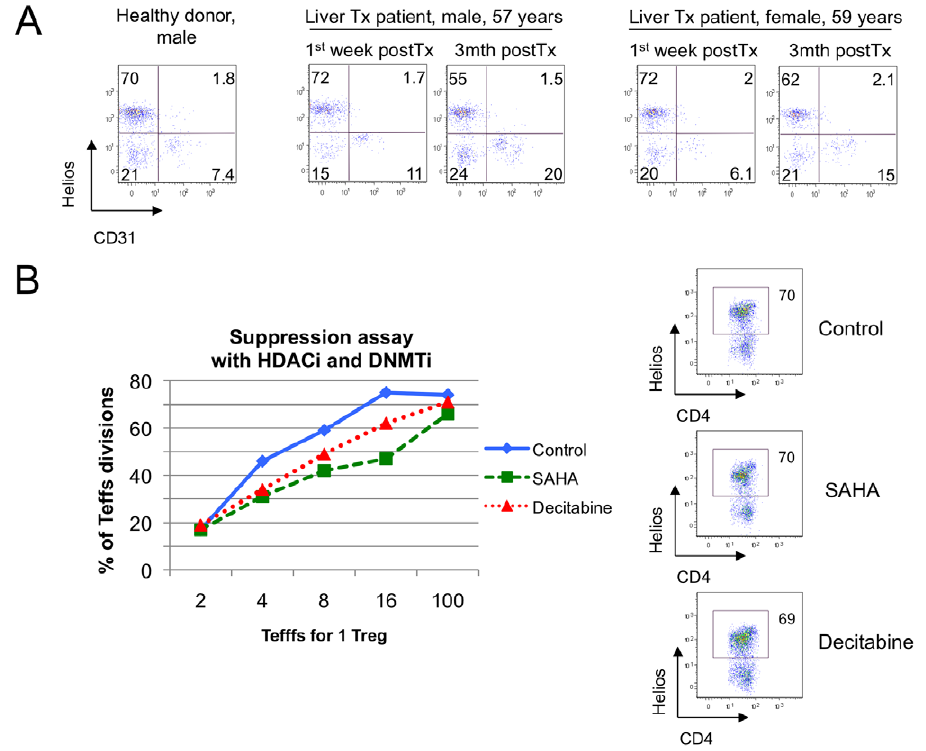
Figure 10. Helios expression by human Tregs did not correlate with CD31 or suppressive function. (A) Two liver transplant patients underwent serial analysis of Treg suppressive function, Foxp3 methylation and cell phenotype. At 3 mths post-transplant, Tregs had increased thymic output of CD31 + Tregs and reduction of Helios + Tregs; Helios was not co-expressed with CD31. (B) Tregs, CD4 + CD25- Teffs and CD4-depleted APC from healthy donor were used in suppression assays, with or without treatment with a DNMTi (Decitabine) or HDACi (SAHA). Enhancement of Treg suppression by either agent (left) was not accompanied by change in Helios expression (right).